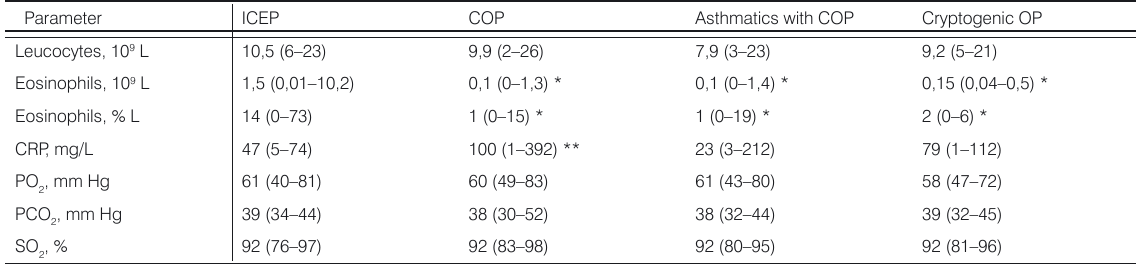
Table 4. Blood tests data of the study